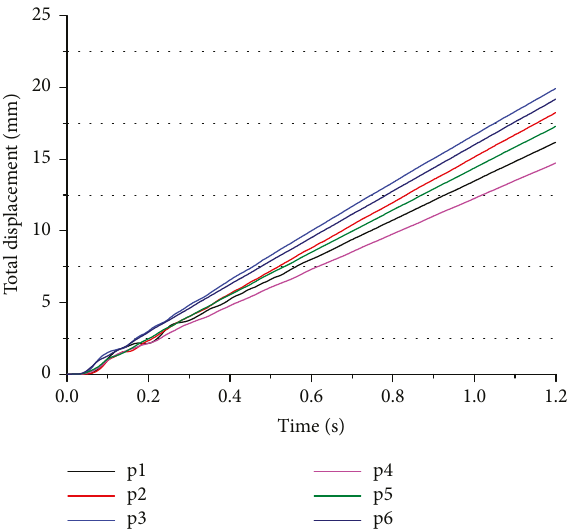
Figure 37: Time-history response curve of resultant displacement at characteristic points on the embankment in the fourth